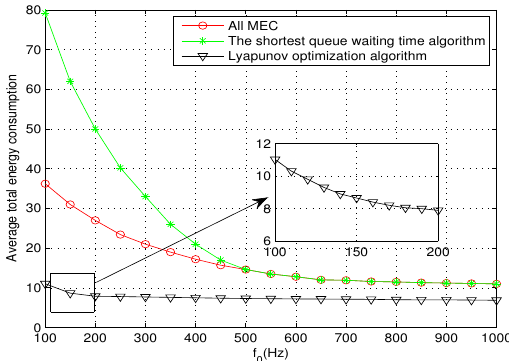
Figure 9. Performance comparison